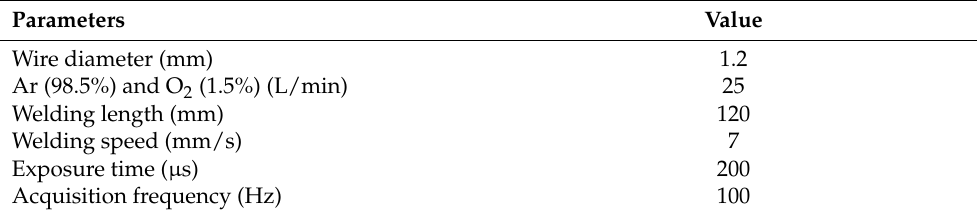
Table 3. Welding